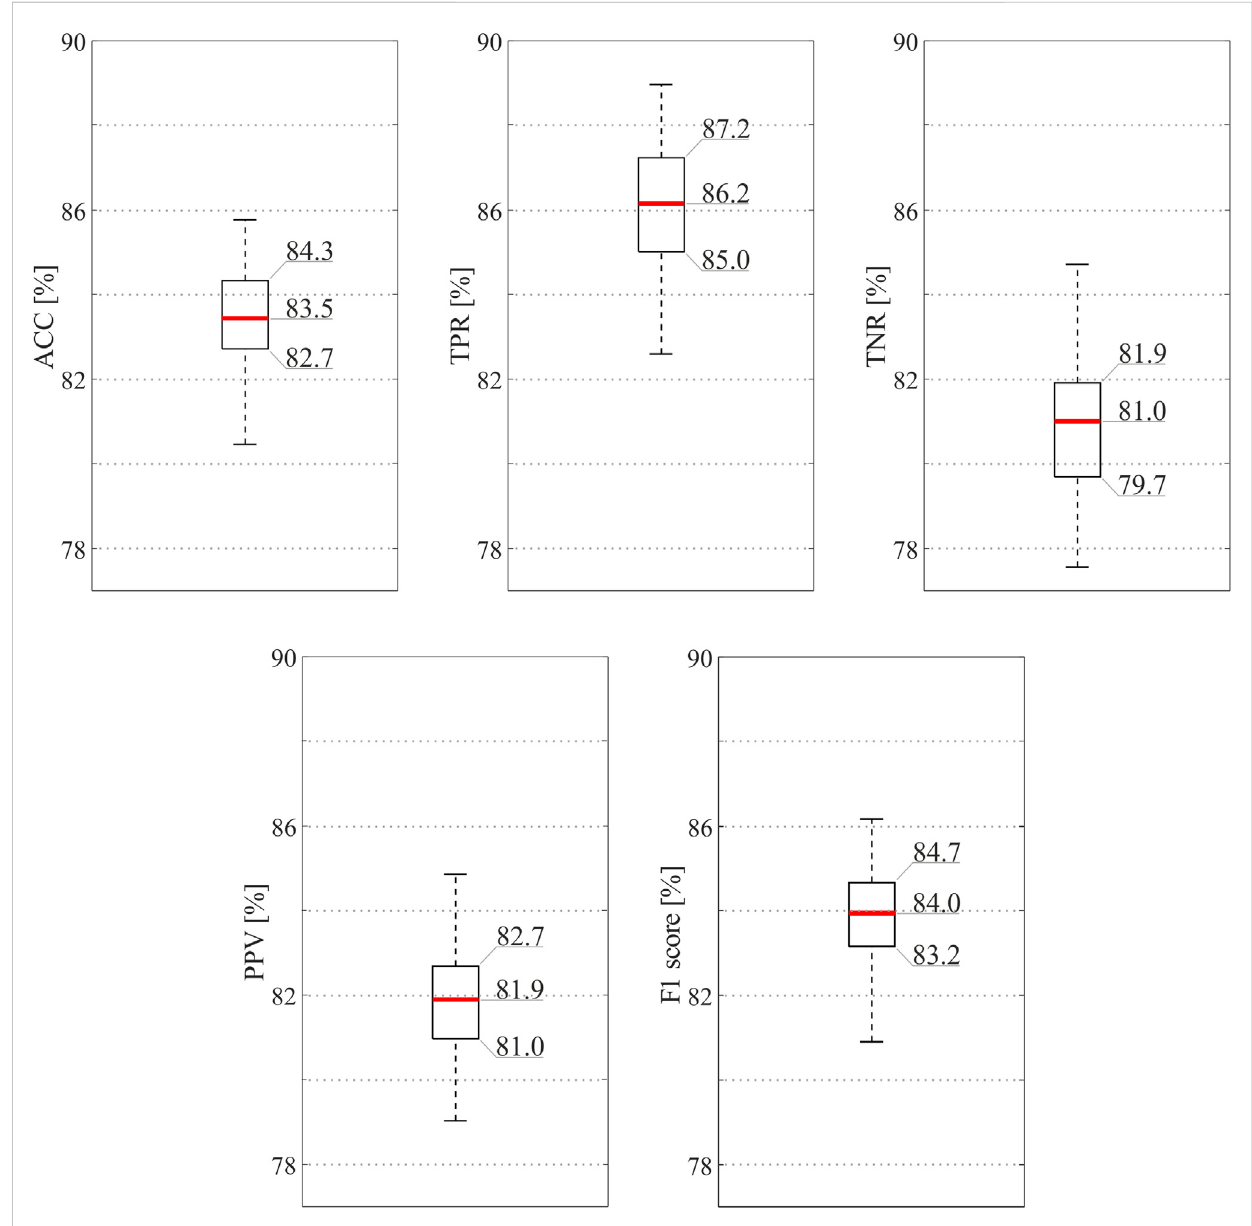
FIGURE 4 SQI-based classi fi cation results obtained by the ensemble tree exploiting only those features selected by the mRMR algorithm. In order to provide the reader with an accurate display of the results, exact values are reported for the 25th and 75th percentiles and for the medians.